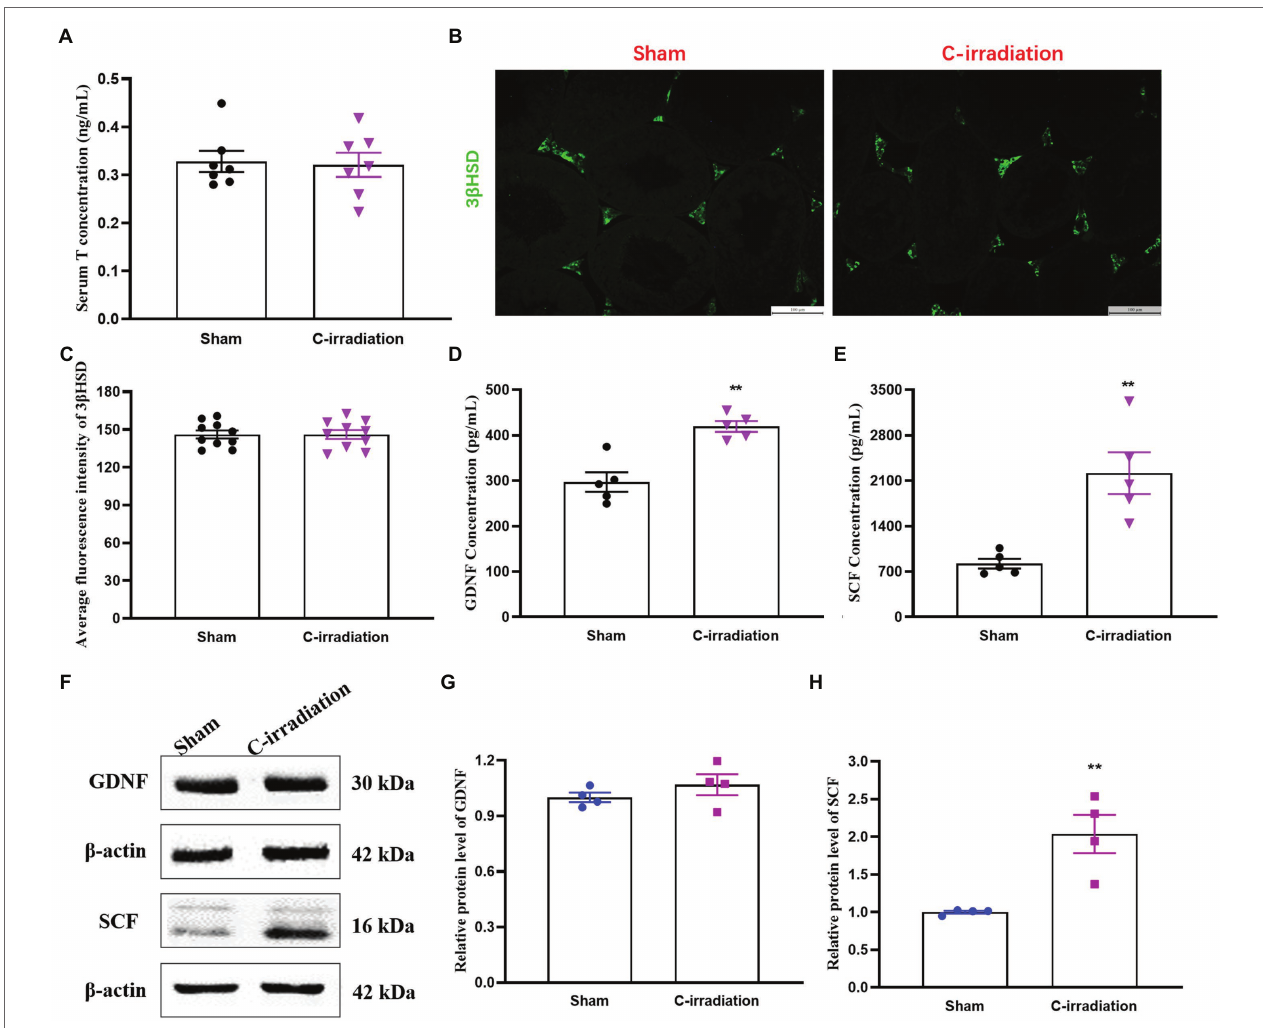
FIGURE 4 | The abscopal effects of C-irradiation affect the secretory functions of the testis. (A) Serum T concentrations secreted by Leydig cells, n = 7 for each group. (B – C) Immunofluorescence of 3 β HSD in testis and average fluorescence intensity from 10 random fields for each group. Bar = 100 μ m. (D–E) GDNF and SCF concentrations secreted by Sertoli cells and detected by ELISA, n = 5 for each group. (F) Typical immunoblots relating to the secretory functions of Sertoli cells. The first two bands were from the same membrane and the last two bands were from another membrane. (G – H) Relative protein level of GDNF and SCF detected by Western blotting, n = 4 for each group. The values are expressed as the mean ± SD and analysed by two-tailed unpaired student’s t -tests. ** p < 0.01 vs. sham